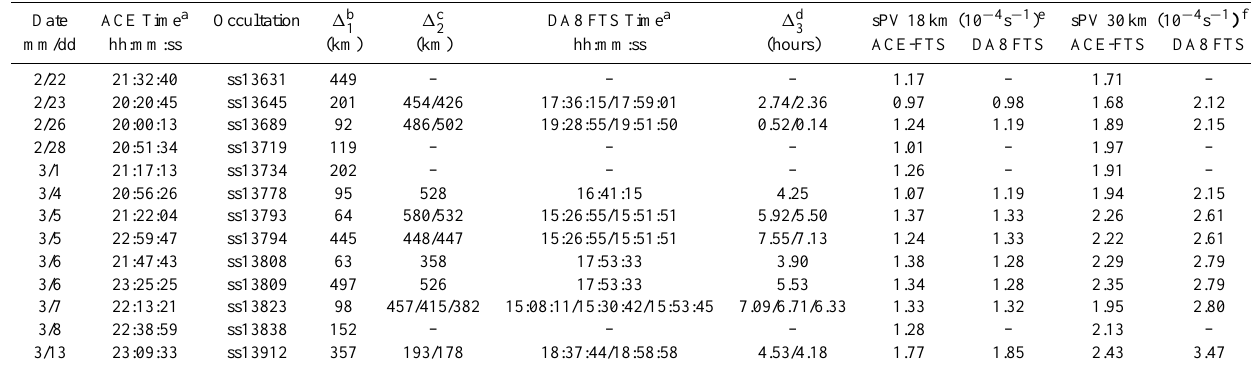
Table 8. The spatial and temporal differences between DA8 and ACE-FTS for HCl and NO 2 during the 2006 Canadian Arctic ACE Validation